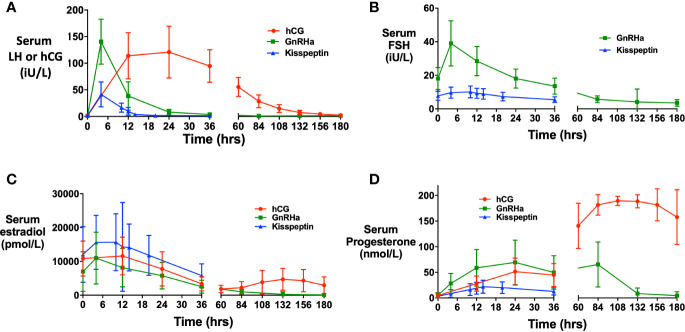
Hormonal responses after each trigger of oocyte maturation. (A) Mean (± SD) of change in serum human chorionic gonadotropin (hCG) levels (iU/L) over time in response to hCG (red), and change in serum LH after GnRH agonist (green) and kisspeptin (blue). (B) Mean (± SD) of change in serum FSH (iU/L) over time in after GnRHa (green) and kisspeptin (blue). (C) Mean (± SD) of change in serum estradiol (pmol/L) over time after hCG (red), GnRHa (green) and kisspeptin (blue). (D) Mean (± SD) of change in serum progesterone (nmol/L) over time after hCG (red), GnRHa (green) and kisspeptin (blue).